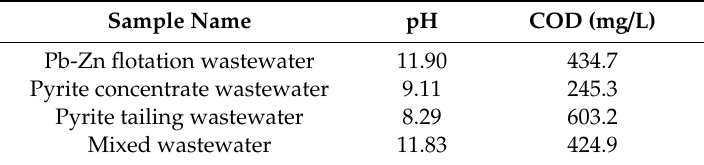
Table 1. Chemical oxygen demand (COD) and pH values of mineral processing wastewater samples in a Pb-Zn beneficiation